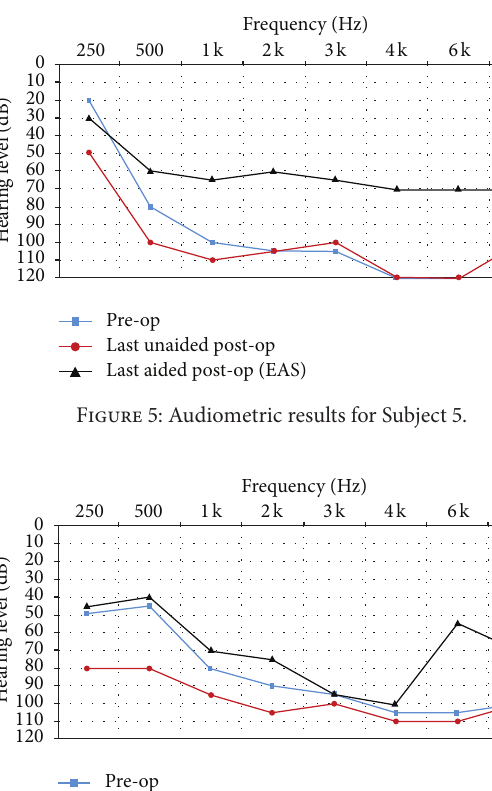
Figure 1: Audiometric results for Subject 1.